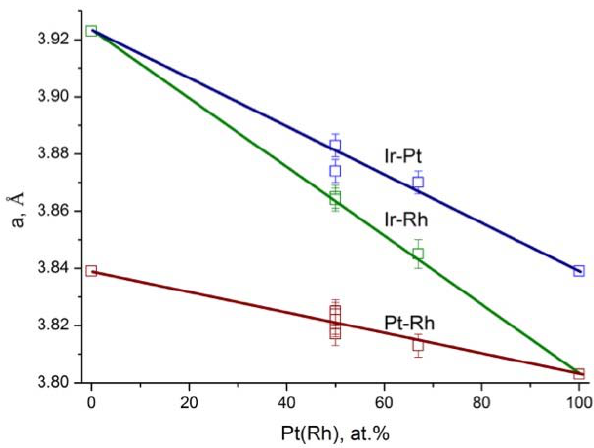
Figure 4. Dependence of cell parameters on composition for fcc -structured Rh, Ir, Pt and Pd single-phase binary alloys (according to Table 1).